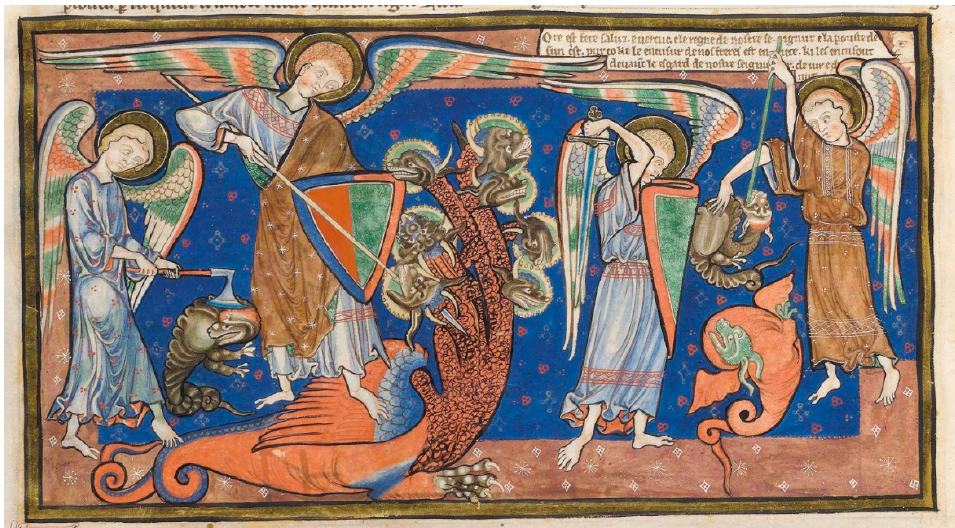
Figure 4. Trinity Apocalypse (Cambridge, Trinity College, MS R.16.2). Fol.13 v , c. 1255–60, © The Master and Fellows of Trinity College, Cambridge.